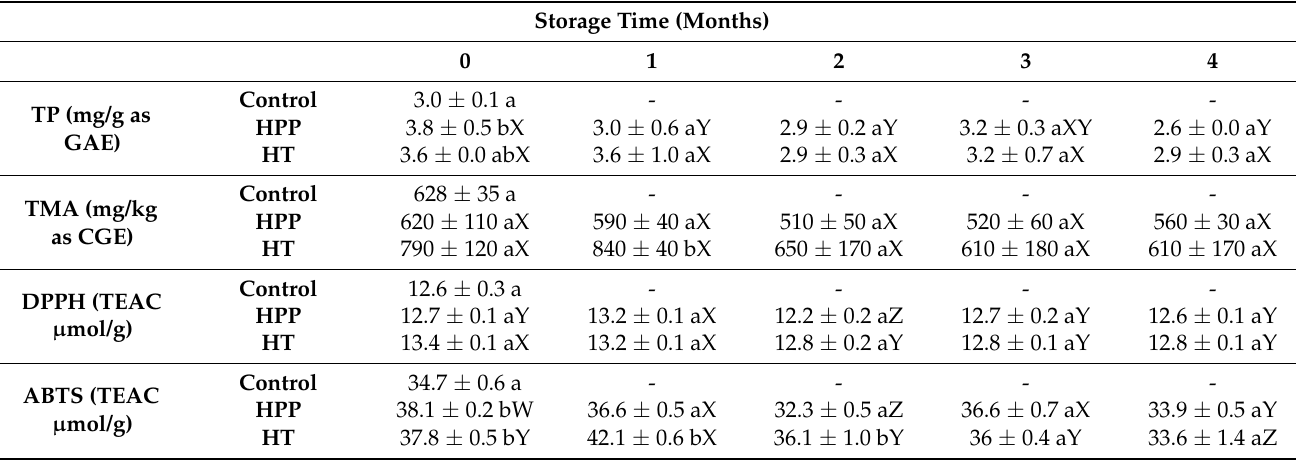
Table 1. Changes in total phenolic (TP) compounds content, total monomeric anthocyanins (TMA) content, and antioxidant activity of whole Concord grape purees during 4 months of storage at 4 ◦ C.